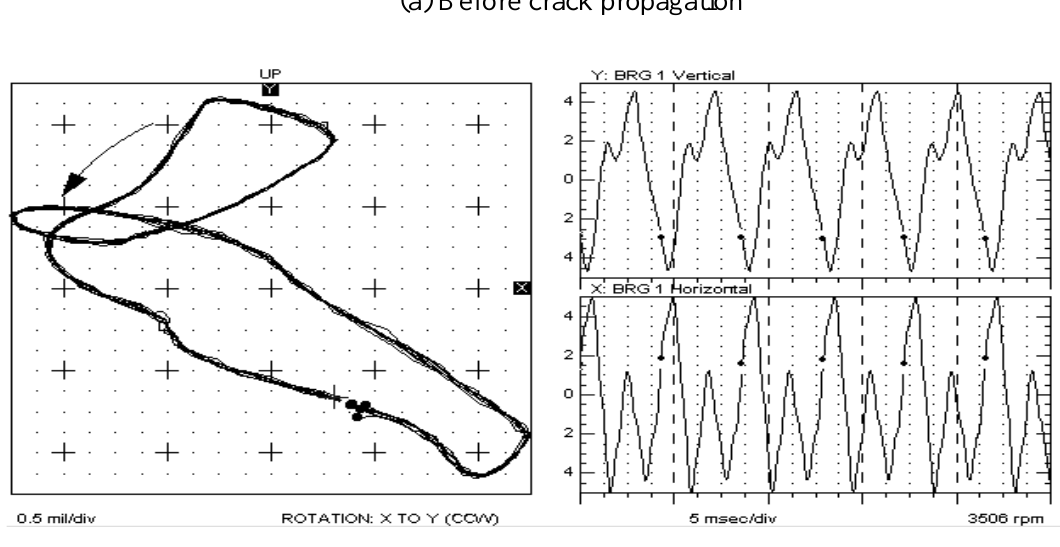
Fig. 13. Orbit of steady state data at 3500 rpm for the 2nd shaft with 4 mm notch crack and 8 kg vertical hanging side load during crack